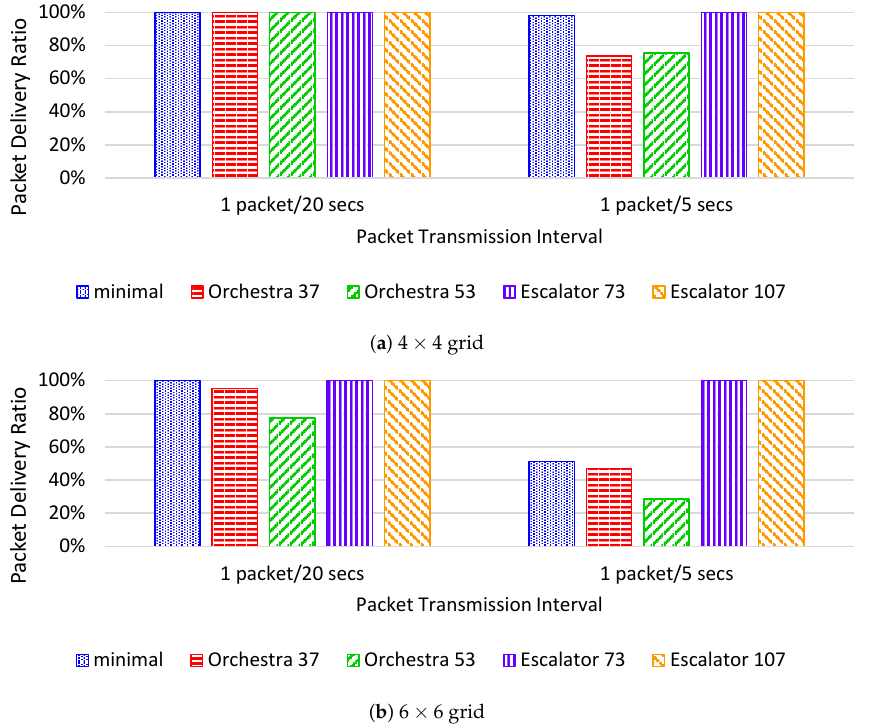
Figure 12. PDR per packet transmission interval in the